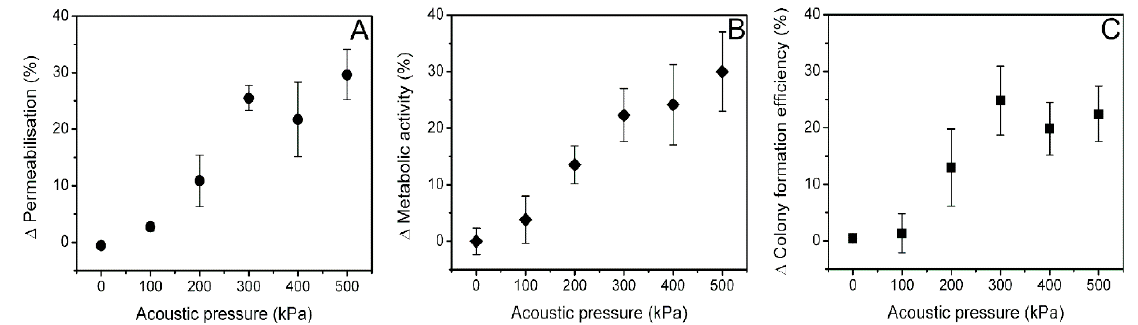
Figure 10. The change ( ∆ ) in cell permeabilization ( A ), cell metabolic activity ( B ), and cell colony formation efficiency ( C ), evaluated as permeabilization, decrease in metabolic activity, and decrease in colony formation efficiency between groups: (Ca 2+ + MB + US) − (MB + US) − (Ca 2+ + MB).